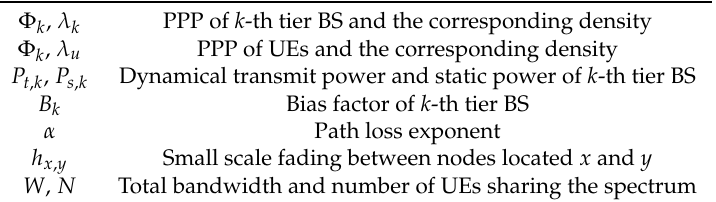
Table 1. Notations used in the paper.